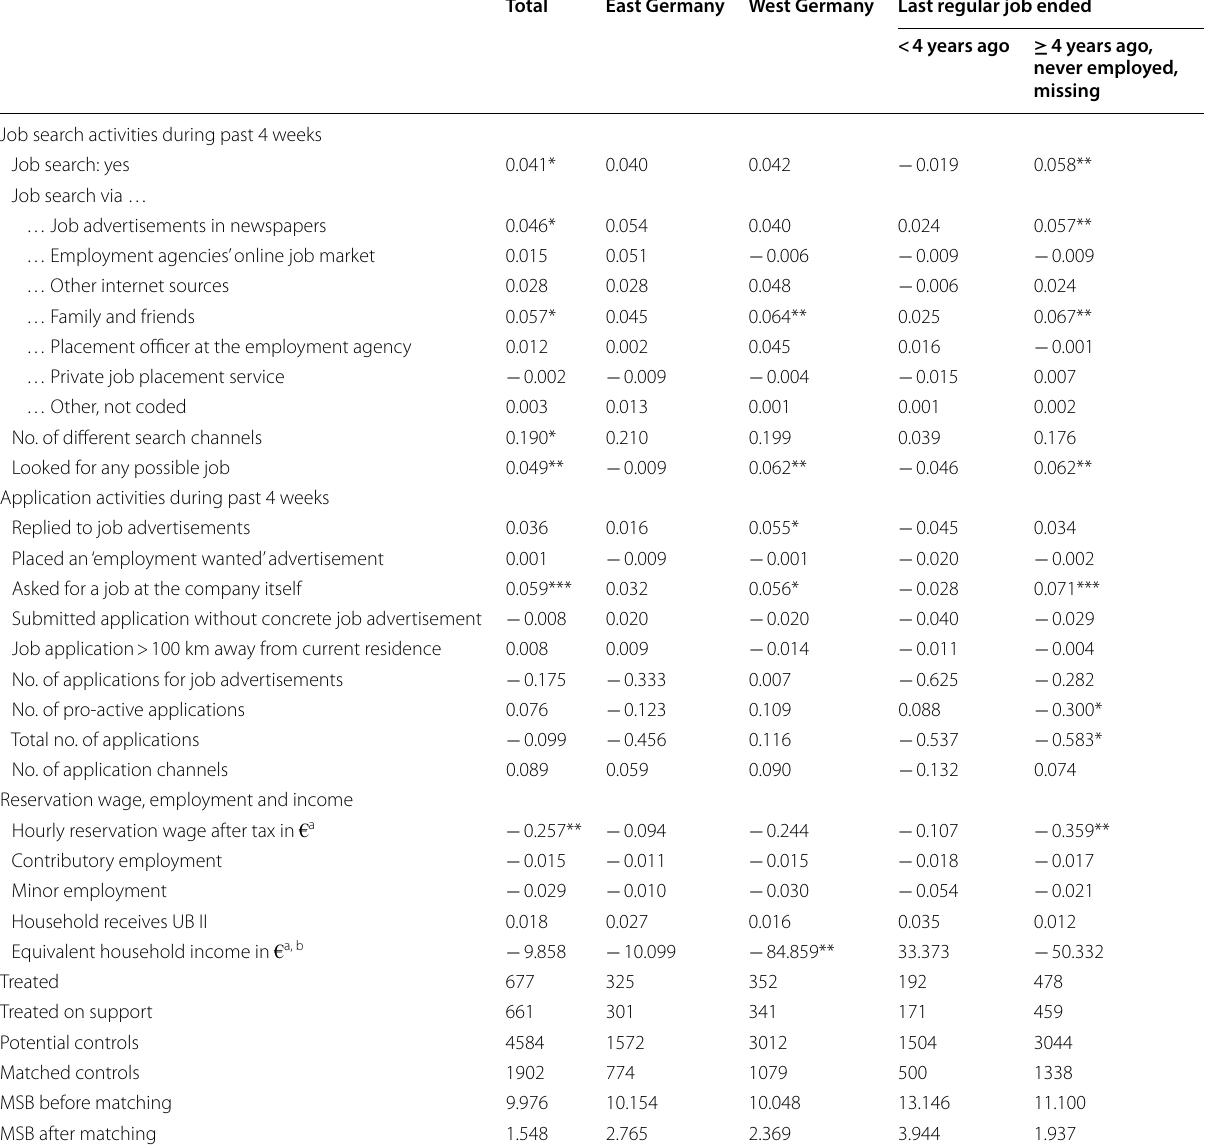
Table 8 Robustness check—ATT of receiving a One‑Euro‑Job announcement, results from nearest neighbour